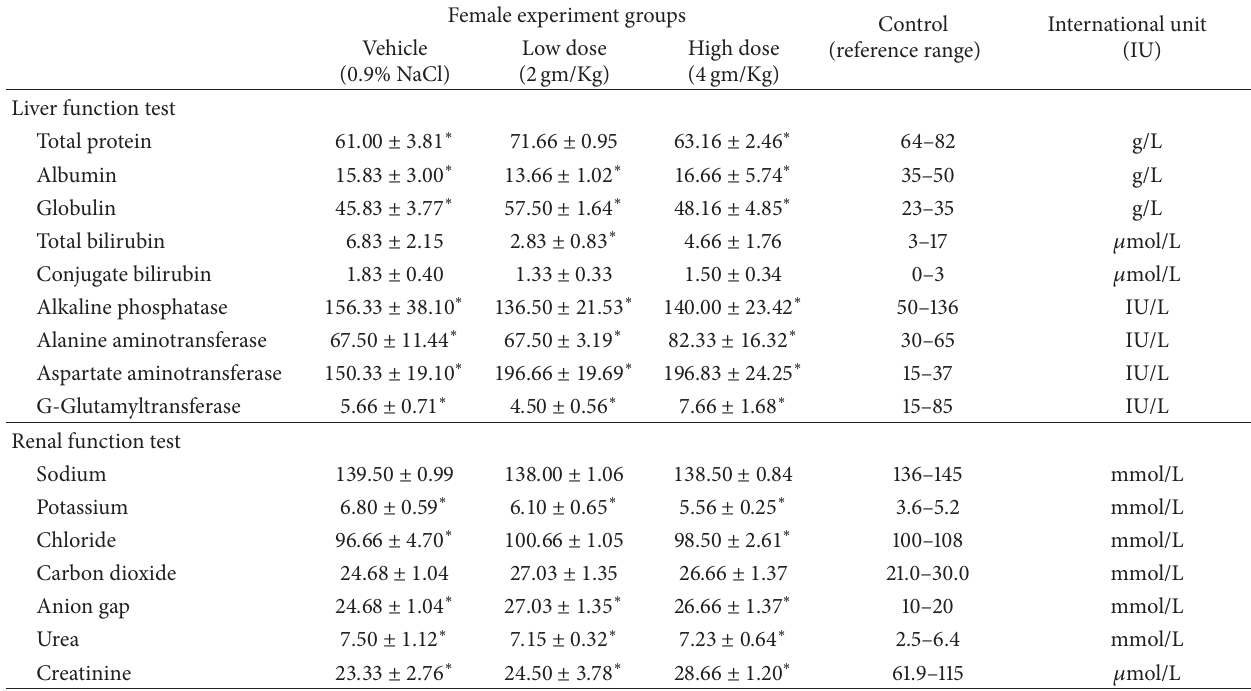
Table 4: Liver and renal function tests among female